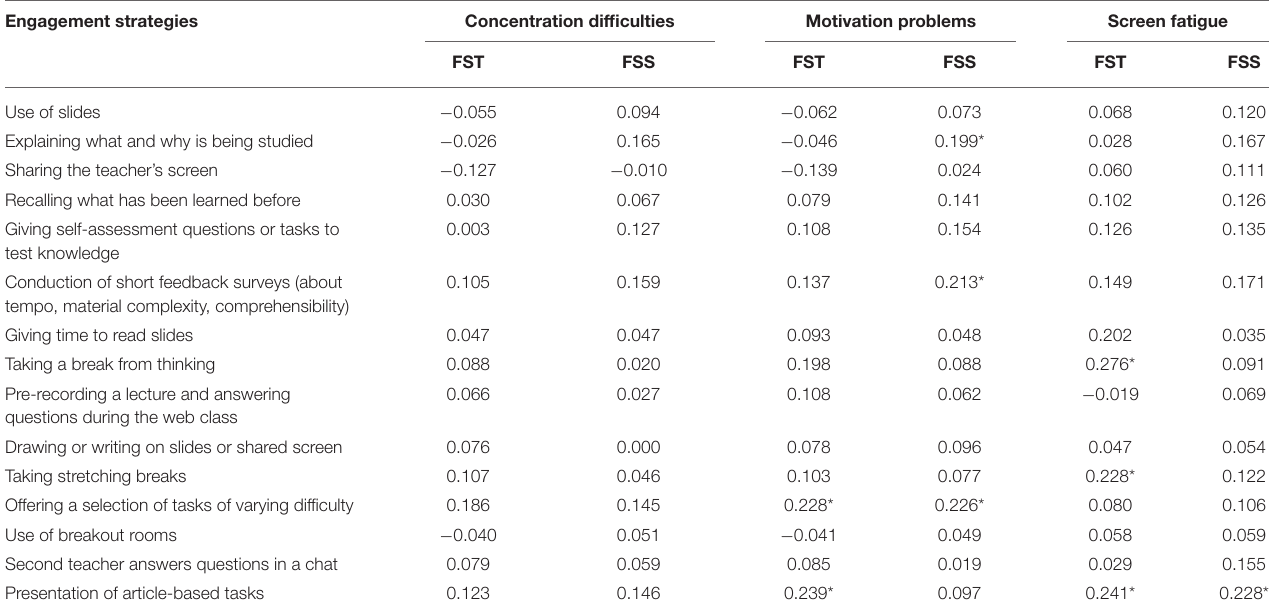
TABLE 5 | Spearman correlation